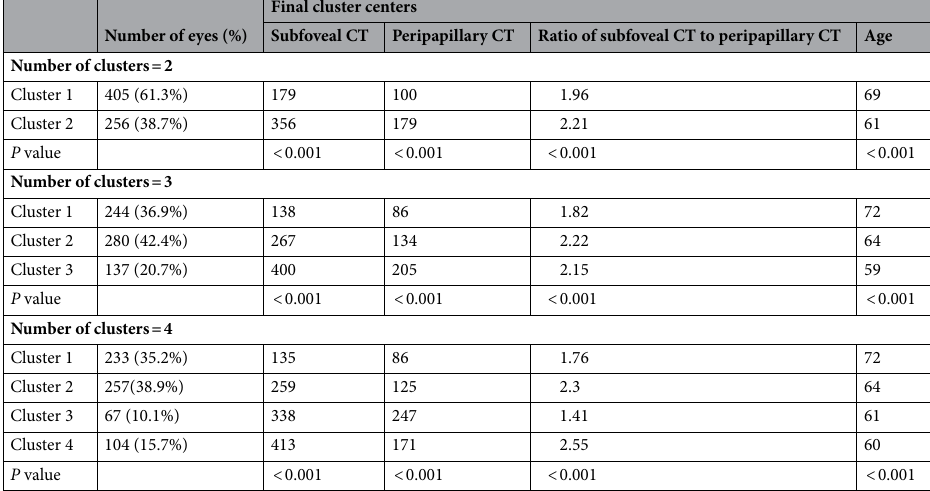
Table 5. Clustering analysis based on choroidal thickness profile and age. CT, choroidal thickness.